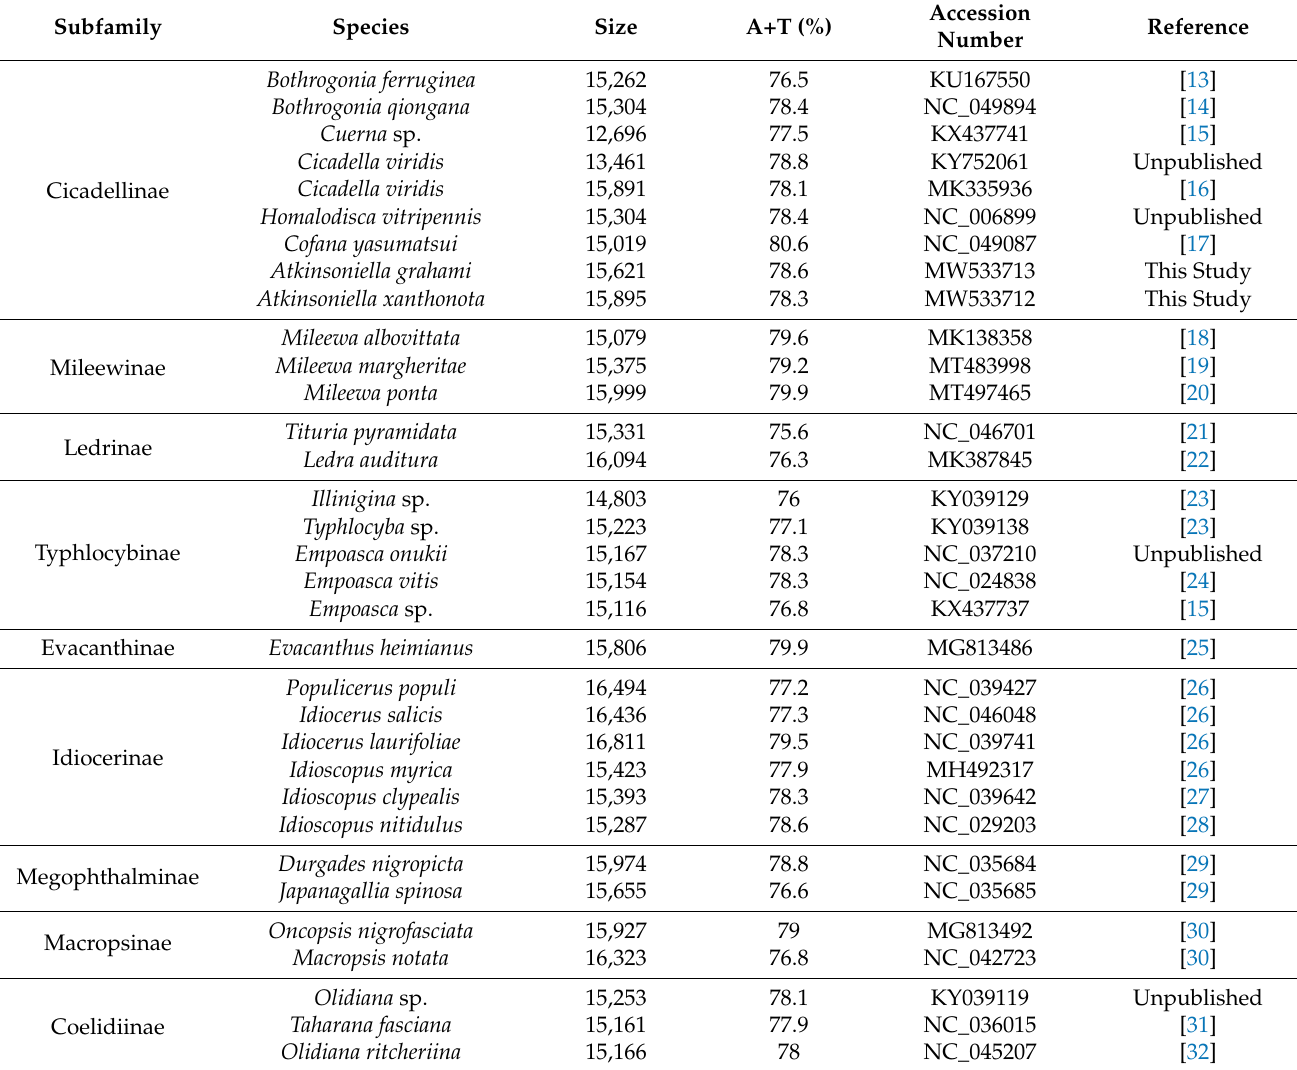
Table 1. Mitochondrial genomes used for the phylogenetic analyses in this